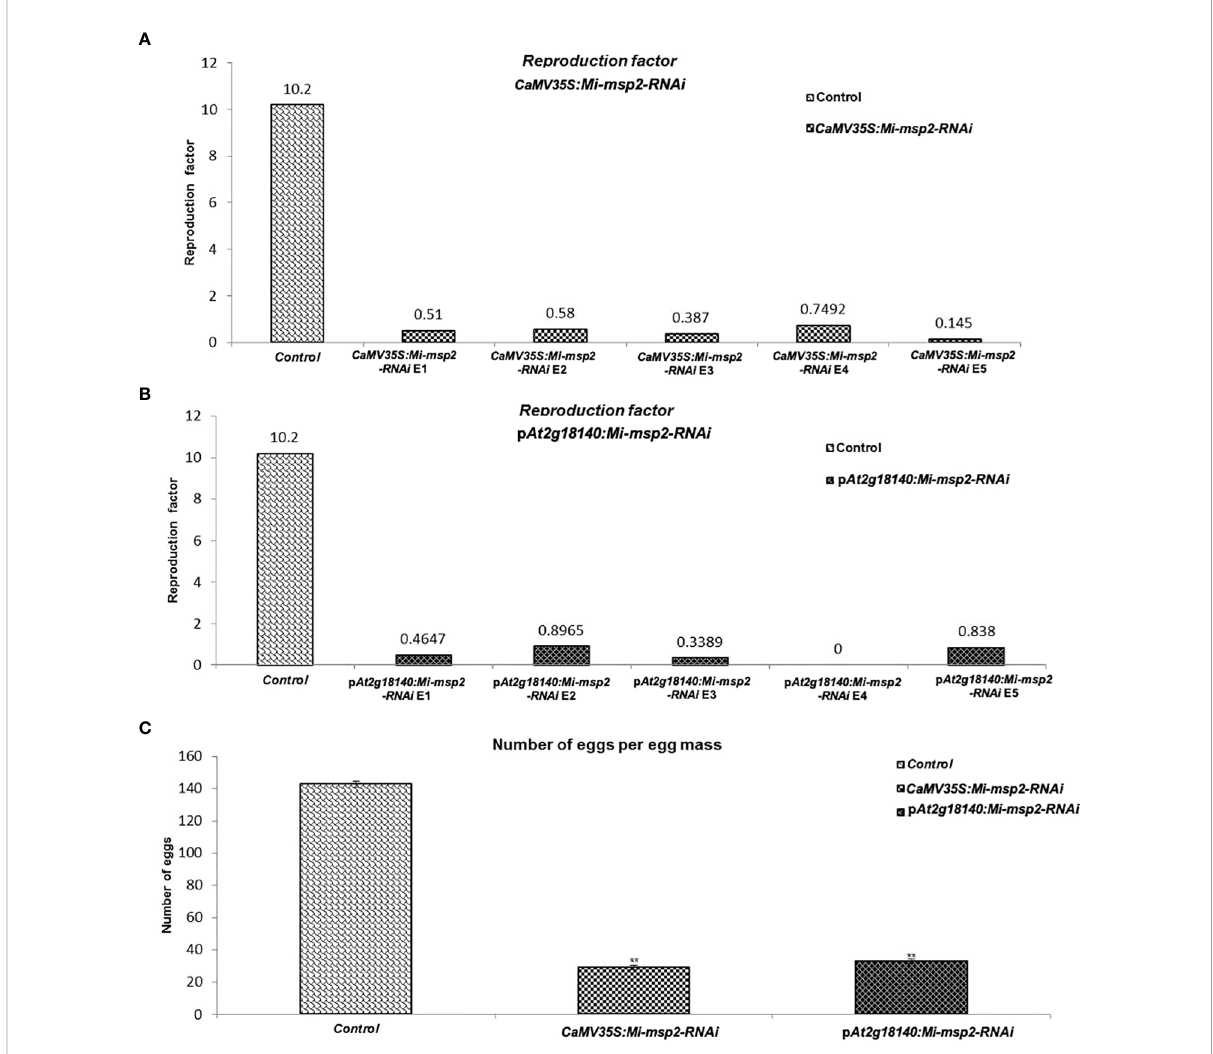
FIGURE 7 Fecundity of M . incognita . (A) Reproductive factors for the control and CaMV35S::Mi-msp2. (B) Reproductive factors for the control and p At2g18140::Mi-msp2-RNAi. (C) The average number of eggs per egg mass isolated from the control and CaMV35S::Mi-msp2-RNAi and p At2g18140::Mi-msp2-RNAi (cumulative egg masses from fi ve lines of each RNAi construct). Each bar represents the mean±SE. Double asterisks indicate statistically signi fi cant differences according to one-way ANOVA and Tukey ’ s test (p ≤